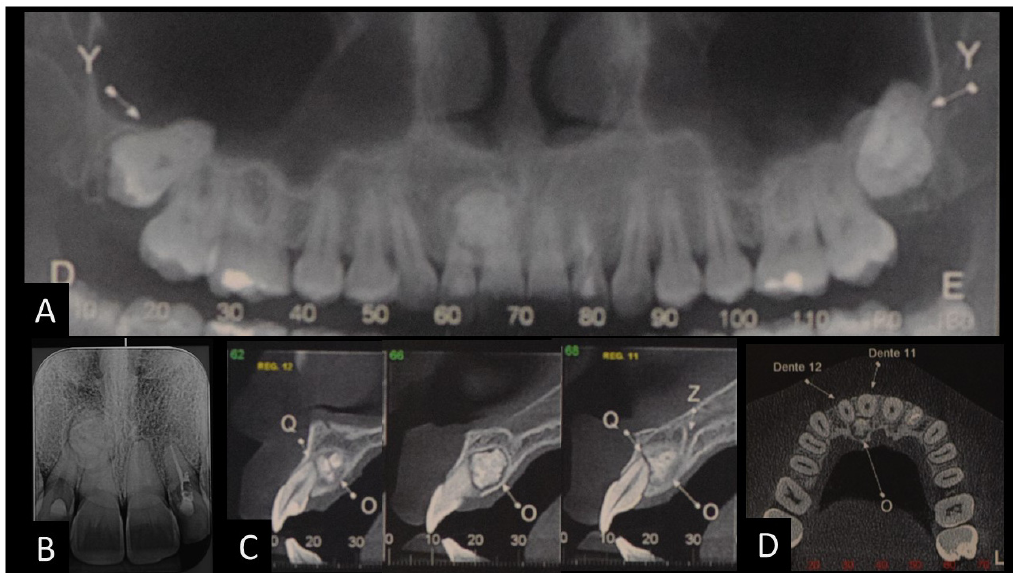
Figure 1. The radiographical diagnosis of complex odontoma. A ) and B ) panoramic and periapical radiography showing radiopaque lesion in the upper right incisors region; C ) tomographic image of the sagittal section showing the relation of the lesion with the apex of the upper right central and lateral incisors; D ) axial reconstruction of